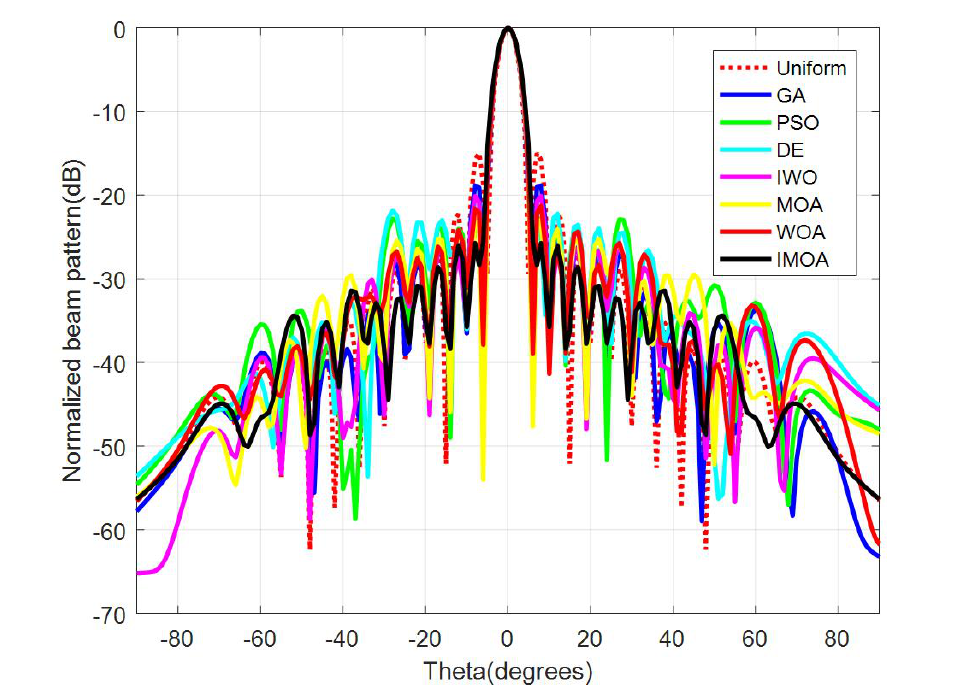
Figure 9. 2D beam patterns of a 528-element planar phased